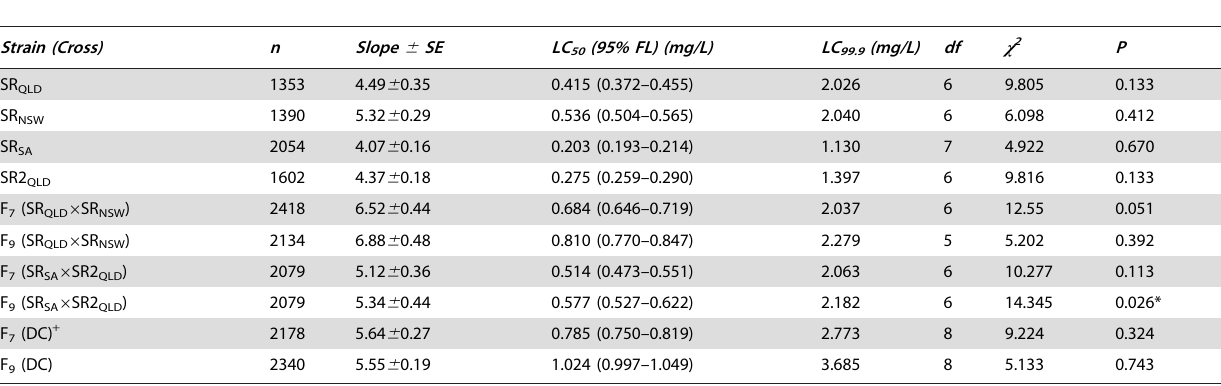
Table 2. Probit analysis results of response of F 7 and F 9 progenies of single and double crosses of four R. dominica strong resistant strains to phosphine